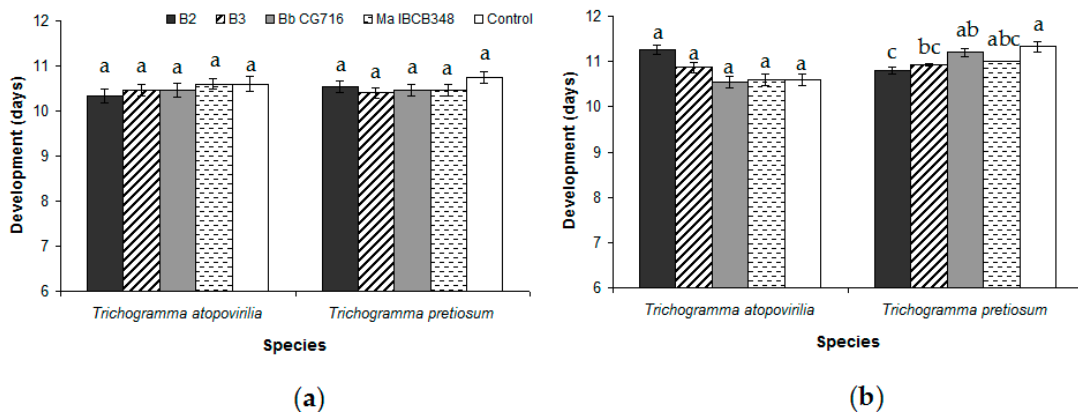
Figure 3. Average length of the egg-to-adult period of development of Trichogramma atopovirilia and Trichogramma pretiosum individuals emerged from Duponchelia fovealis eggs sprayed with Beauveria bassiana strains (B2 and B3) and commercial bioinsecticides (Bb CG716 and Ma IBCB348) pre- ( a ) and post-parasitism ( b ). Error bars are standard errors (n = 15). Small letters over the bars indicate significant differences among treatments according to the Tukey HSD test ( p -value < 0.05).